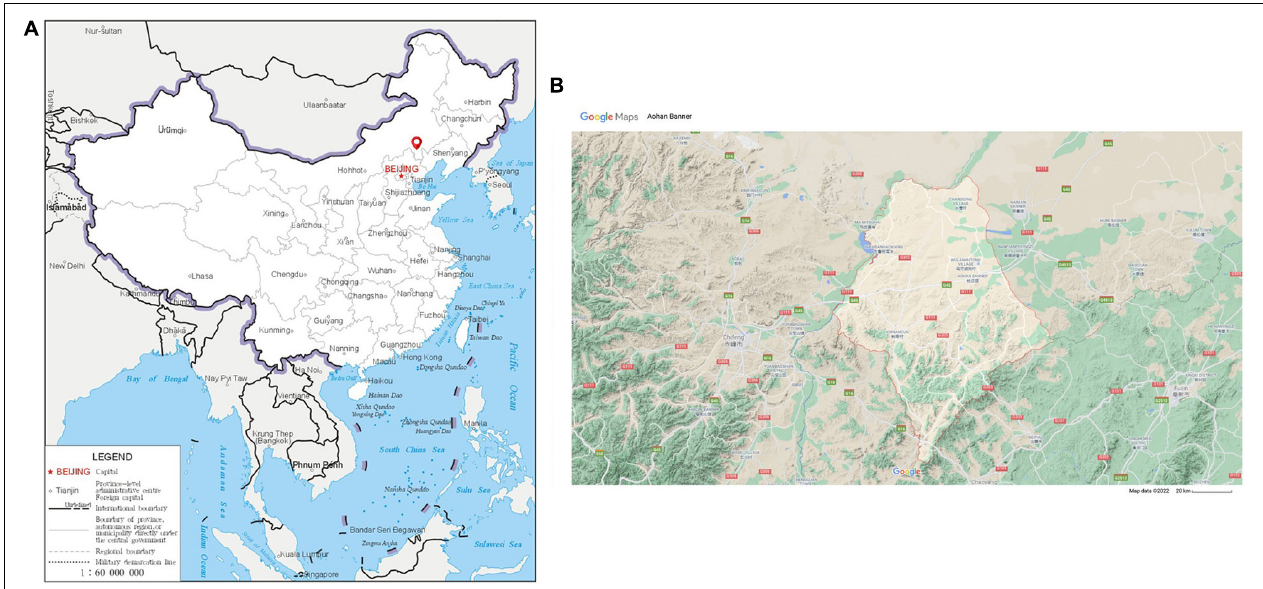
FIGURE 1 | The sampling site of this study was Aohan Banner. (A) The geographic location of raising Aohan fine-wool sheep is indicated by red coordinates. Map from the China Department of Natural Resources. Approval number: GS(2019)1652. (B) The red marks indicate the geographical areas where the Aohan fine-wool sheep live; these areas have a semi-desertified grassland environment. The scale bar is 20 km, source: Google Maps.